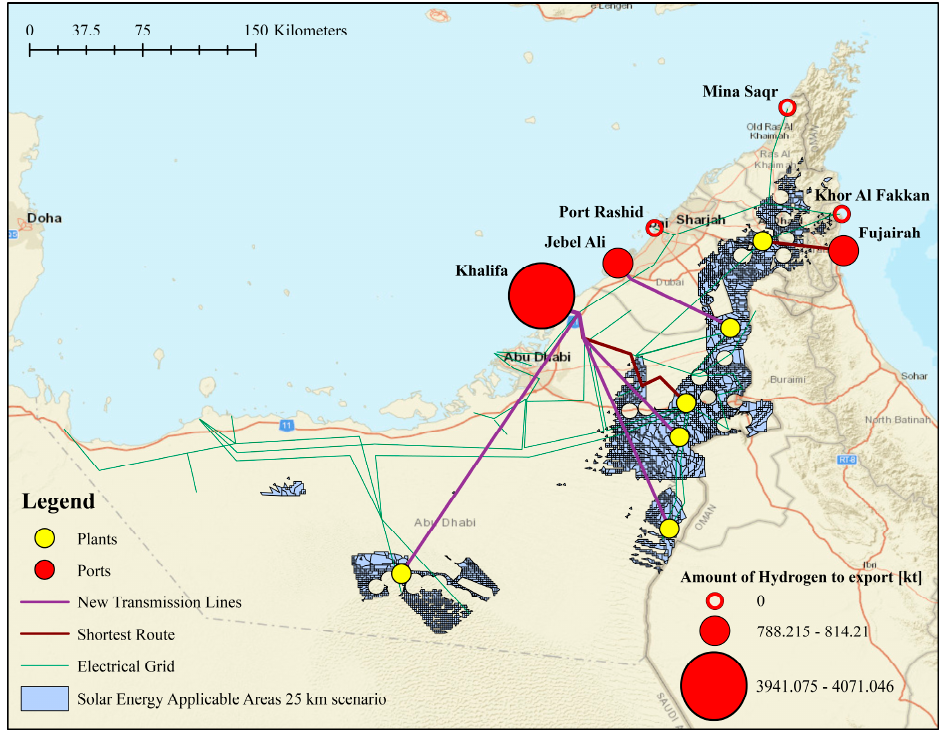
Figure 11. Proposed shortest electrical grid routes from hydrogen plants to export ports.